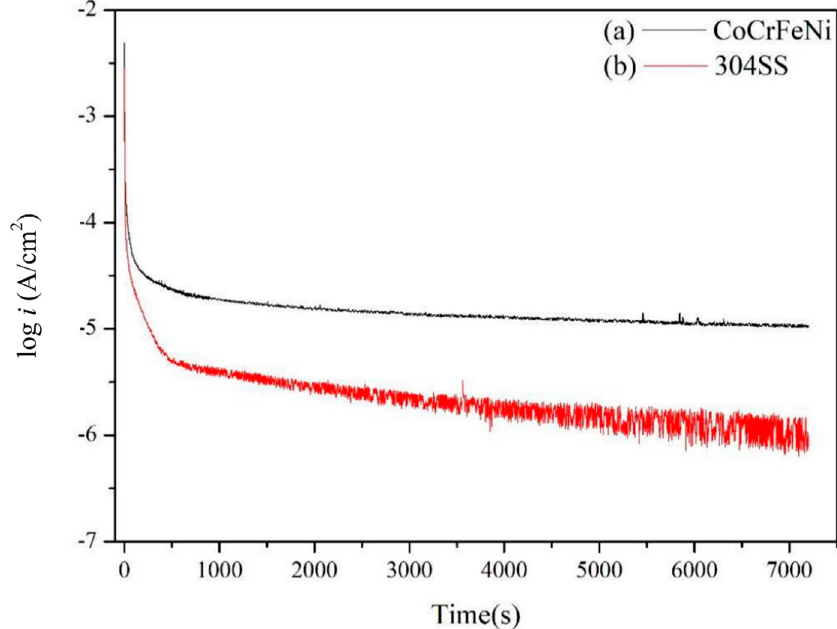
Figure 4. Current densities of (a) CoCrFeNi HEA and (b) 304SS at constant potential 0.6 V for 2 h.